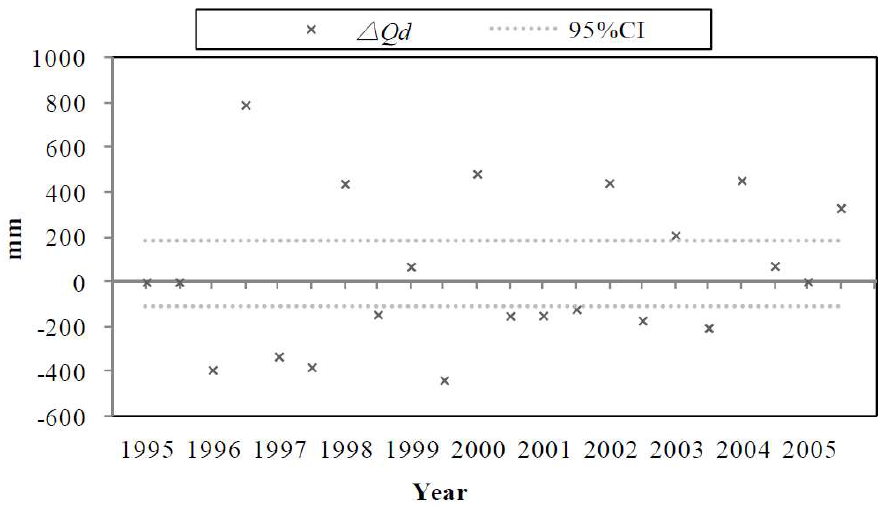
Figure 7. The distribution of seasonal streamflow variation attributed to others (Δ Q d ) and its 95% CI.